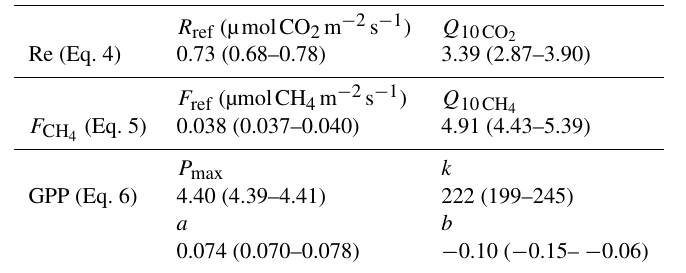
Table 3. Parameters of the fits for Re, GPP and F CH parentheses.